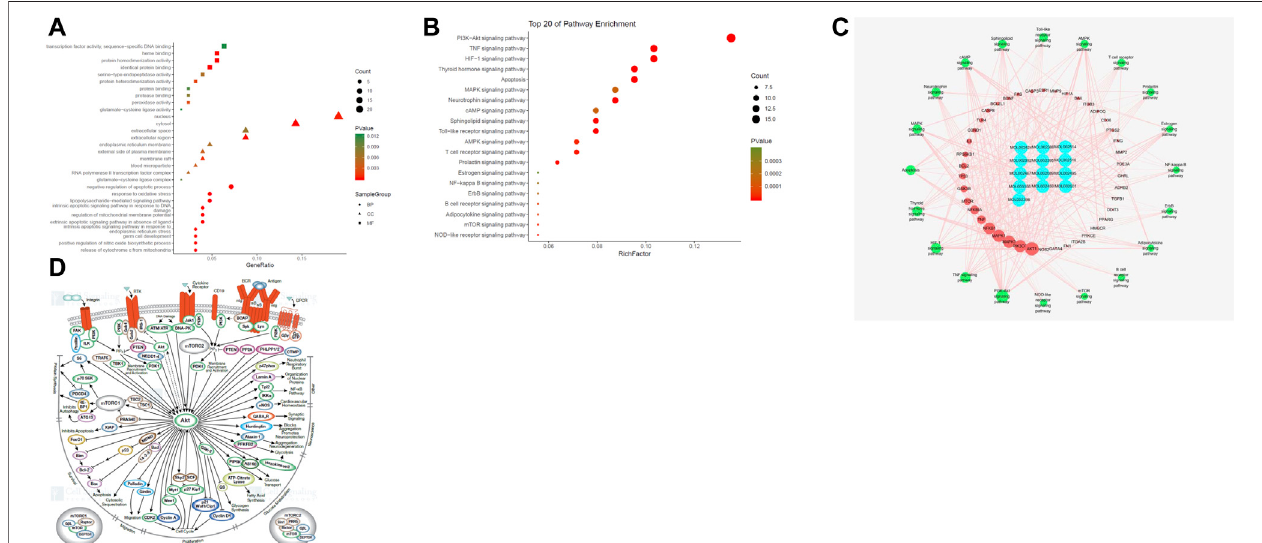
FIGURE2|(A) Thegeneontology(GO)enrichmentanalysisforkeytargets. (B) TheKEGGpathway enrichmentanalysisofkeytargets. (C) Thecompound-target- pathwaynetworkconstructedbyCytoscape.ThebluenodesrepresentactivecomponentsinDAD,therednodesrepresentputativetargets,thegreennodesrepresent thesignalingpathways.Node ’ ssizeisproportionaltotheirdegree. (D) PI3K/Aktsignalingpathwaynetwork(PI3K/Aktsignalingpathwaynetworkisderivedfromhttps://